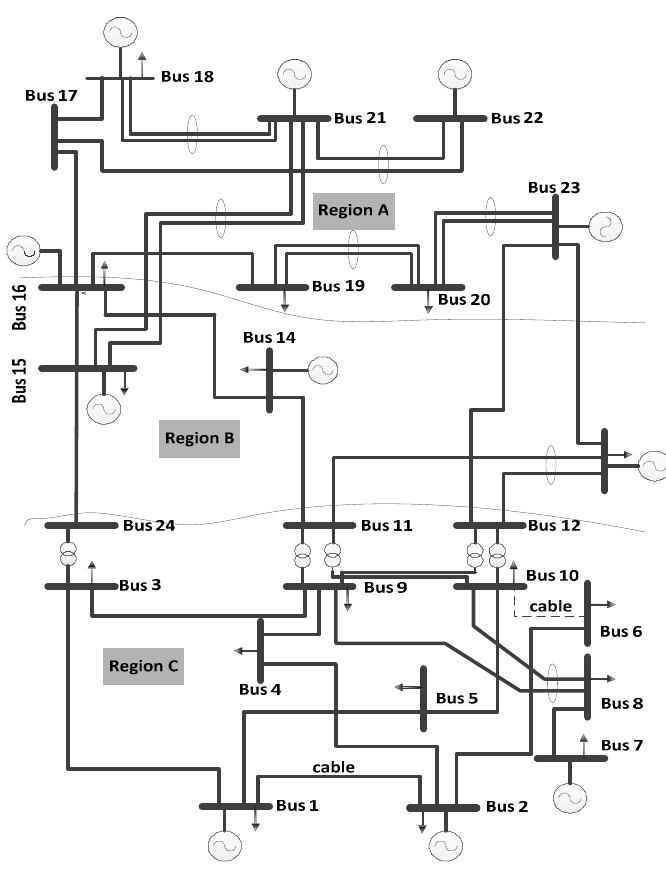
Figure 2. The enhanced IEEE RTN.